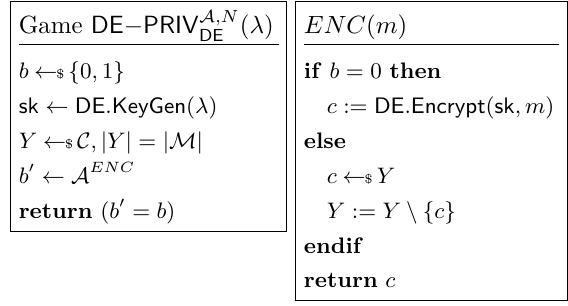
Figure 4: The message privacy game for a DE scheme. We assume that A does not repeat